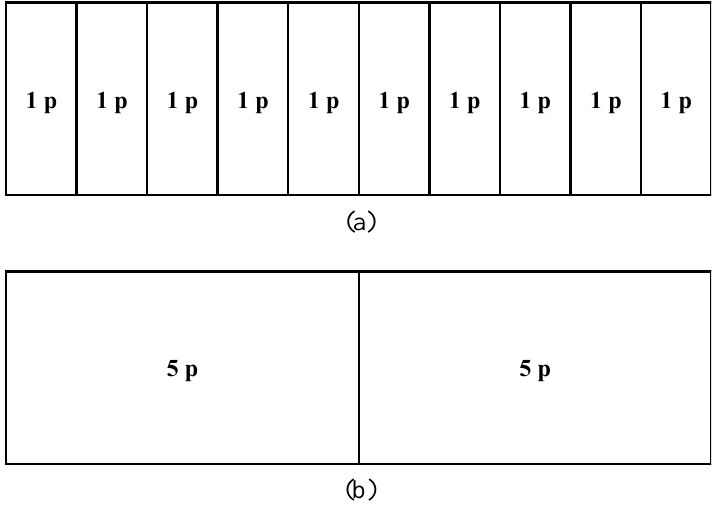
Figure 4. Illustration of two different building layouts: ( a ) 10 single-person rooms; ( b ) 2 five-person rooms.